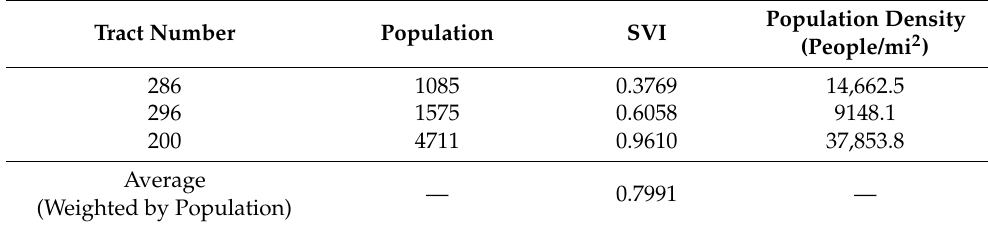
Table 3. Tabulated weighted SVI for three census tracts around Montefiore Medical Center.